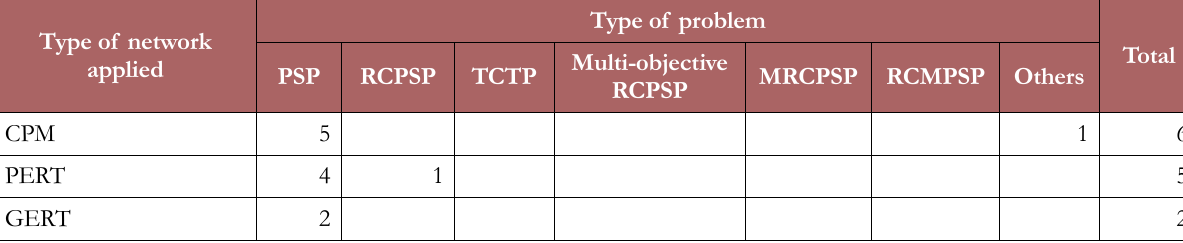
Table 9. Type of Network